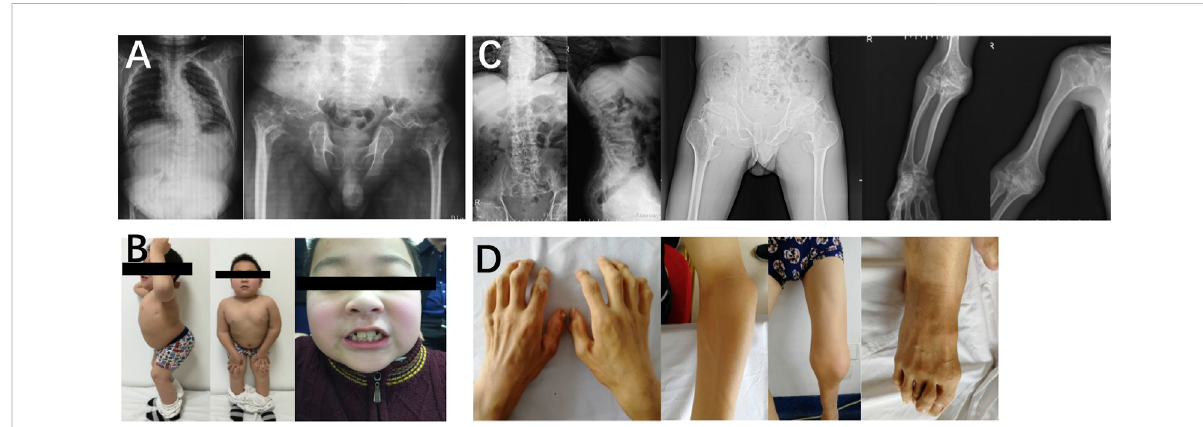
FIGURE 4 Photographs and radiographs of the families 3 and 4 with COL2A1-related skeletal dysplasia. (A,B) Radiographs of the spine and pelvis (A) and photographs of overall body and face (B) of proband 3 ( Ⅱ -1) in family 3. (A) Scoliosis and platyspondyly were shown in the spine. Flattening and irregularity of the acetabular roof, femoral head necrosis, and disappearance of the femoral neck were visible in the pelvis. (B) Barrel chested and limited hip movement were performed in the overall body. No eruption of bilateral incisors was displayed in the face. (C,D) Radiographs of the spine, pelvis, and upper limb (C) and photographs of hands, elbows, knees, and feet (D) of proband 4 ( Ⅱ -1) in family 4. (C) Severe multiple compressions of the vertebral bodies was revealed in the spine. Flattening of the acetabulum, shortening of the femoral neck, enlargement of the trochanter and femoral head, and narrow joint space of bilateral hips were shown in the pelvis. Widened epiphysis and metaphysis and joint cavity stenosis were visible in the elbows. (D) Bilateral elbow, knee, ankle, multiple metacarpophalangeal and interphalangeal joints were